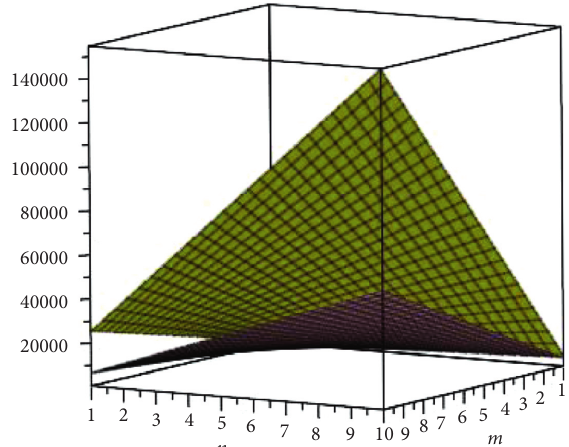
Figure 5: Graph for ( α � 2 ) mn ( 2 4 2 + 2 3 2 + 1 + 3 . 4 2 ) − m ( 2 3 2 + 1